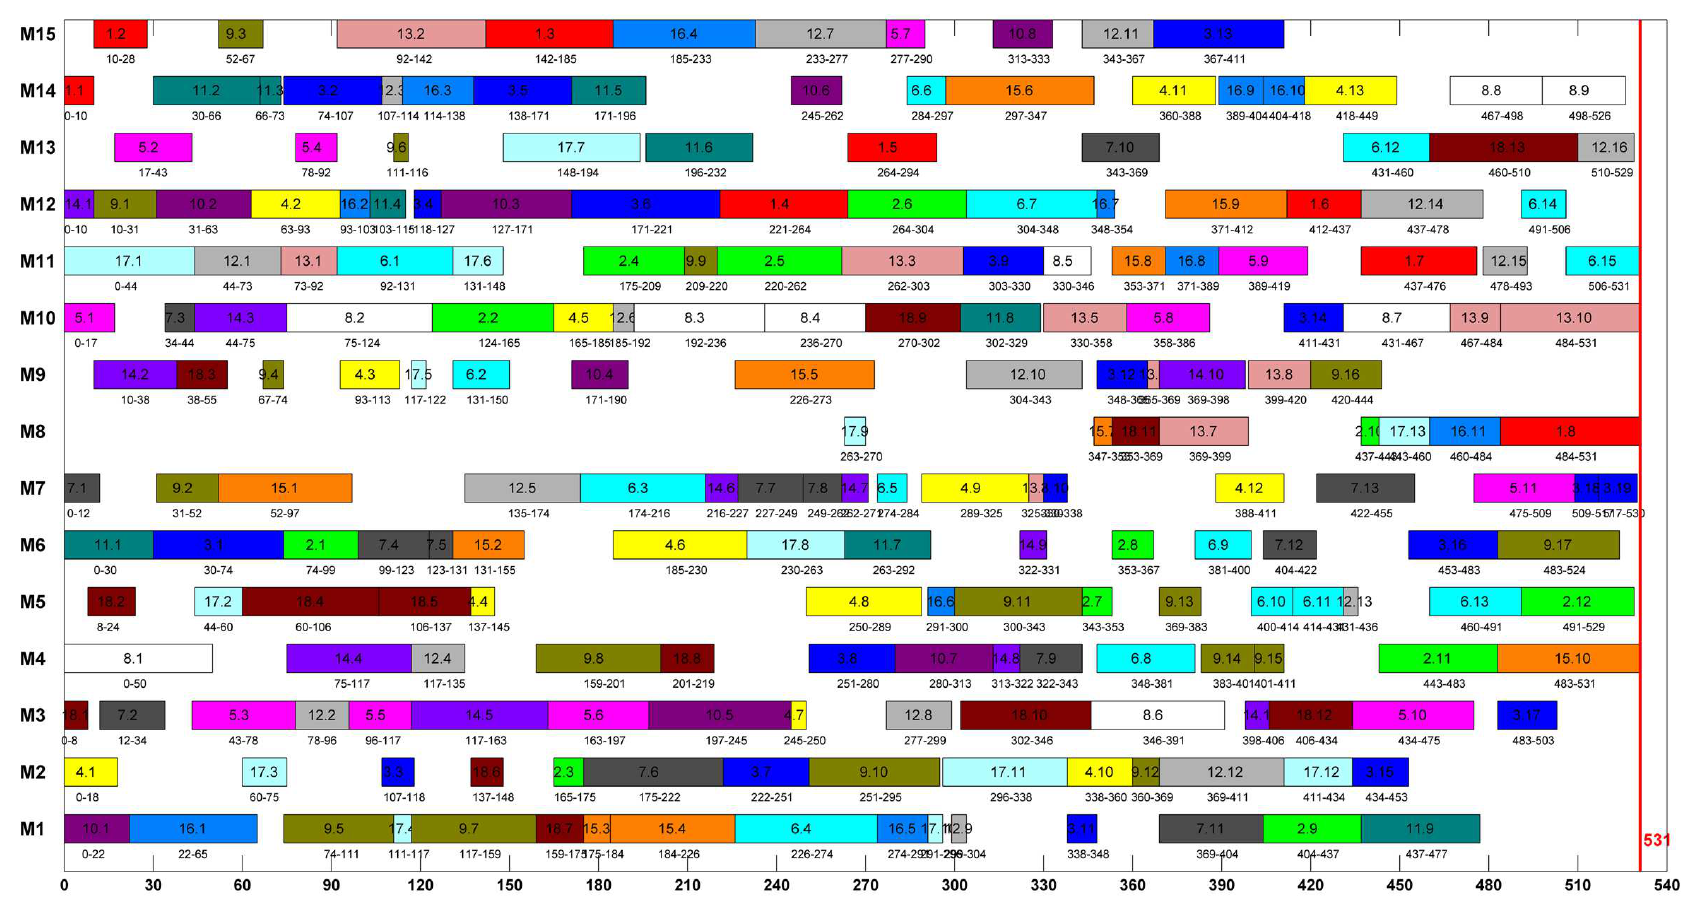
Figure 7. The Gantt chart that mainly considers the makespan